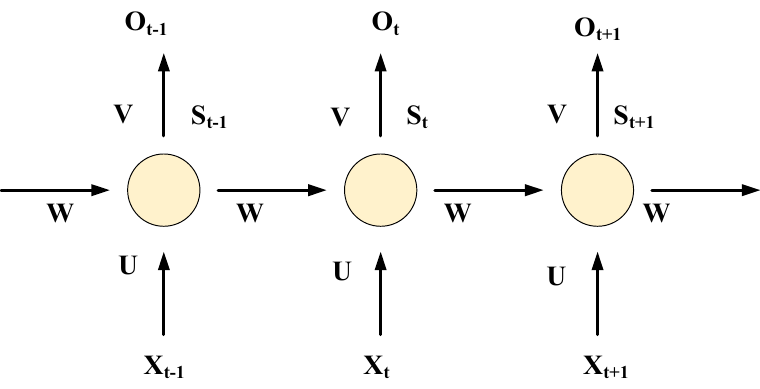
Figure 4. The basic unit memory cell.